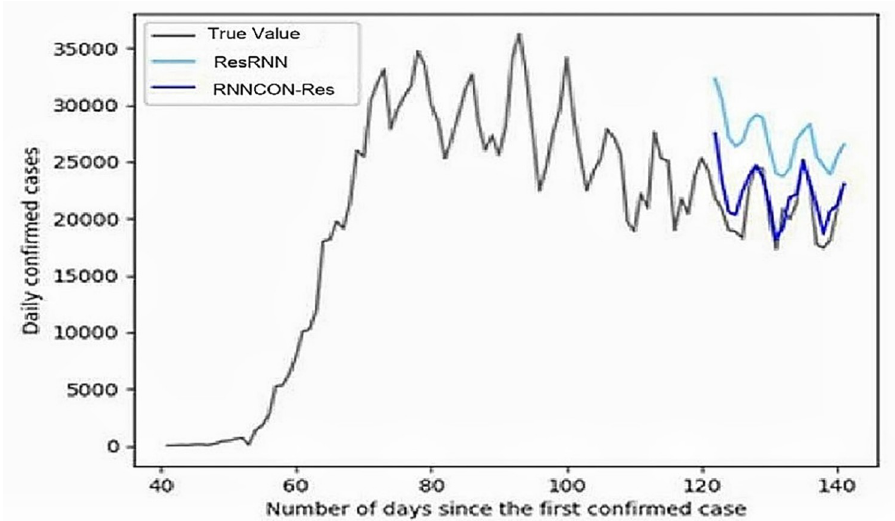
Fig 3. Comparison of the number of covid case predictions using RNNCON-Res and ResRNN with true value.